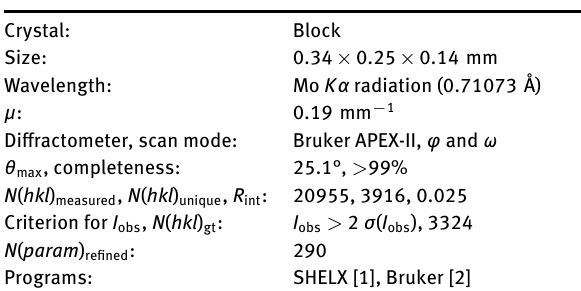
Table 1: Data collection and handling.